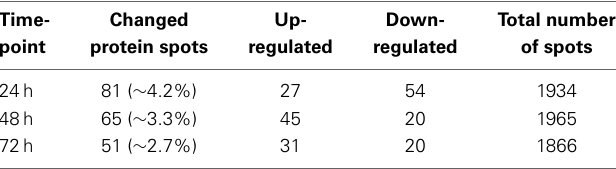
Table 2 | IL-18 treatment induced protein changes in differentiated SH-SY5Y cell lysates, including alteration in levels and modifications, vs. to untreated control at different time-points (DeCyder spot detection -software).